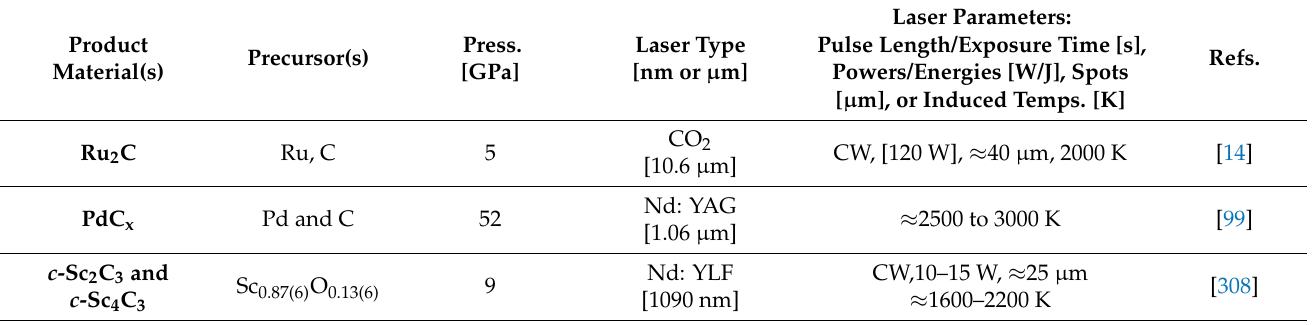
Table 4. Binary Metal Carbides: Metal Carbides Synthesised During Selected LRS-DAC Studies.